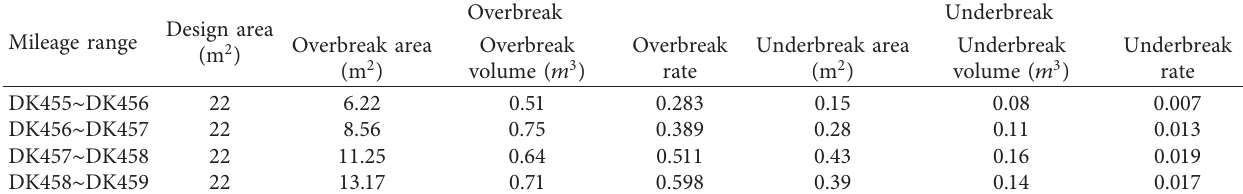
Table 3: Statistical table of the tunnel overbreak and underbreak dimensions.